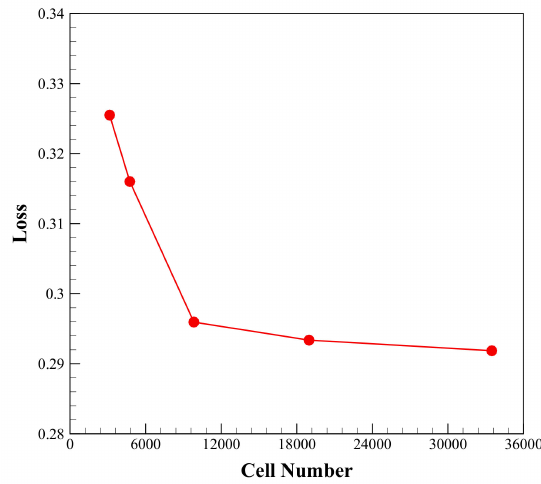
Figure 24. Effect of grid size on the flow losses.